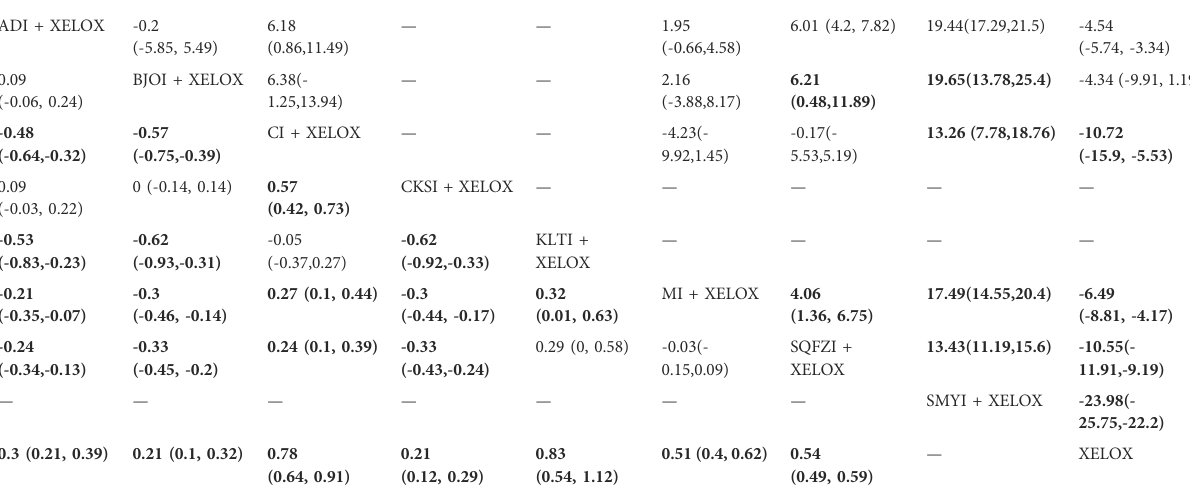
TABLE 4 Results (RR, 95% CI) of Network Meta-Analysis for CD3 + (Upper Right section) and CD4+/CD8+ (Lower Left section). ADI +